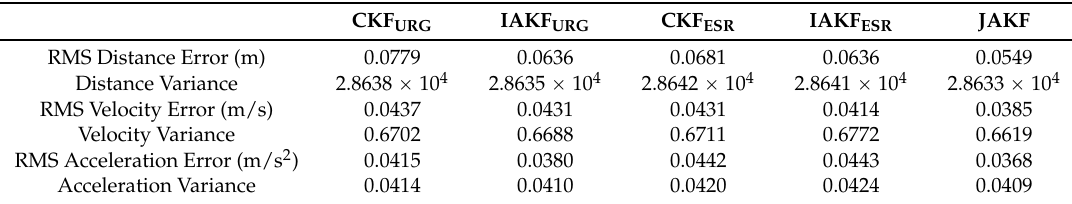
Figure 19. Estimation and error comparison of ESR in the third experiment: ( a ) Displacement estimation of ESR; ( b ) Displacement error of ESR; ( c ) Velocity estimation of ESR; ( d ) Velocity estimation of ESR; ( e ) Acceleration estimation of ESR; ( f ) Acceleration error of ESR. Table 5 lists the comparisons of CKF, IAKF and JAKF about root-mean-square error, maximum error, and variance of filtered results. Table 5. Error comparisons of CKF, IAKF, and JAKF in third experiment.